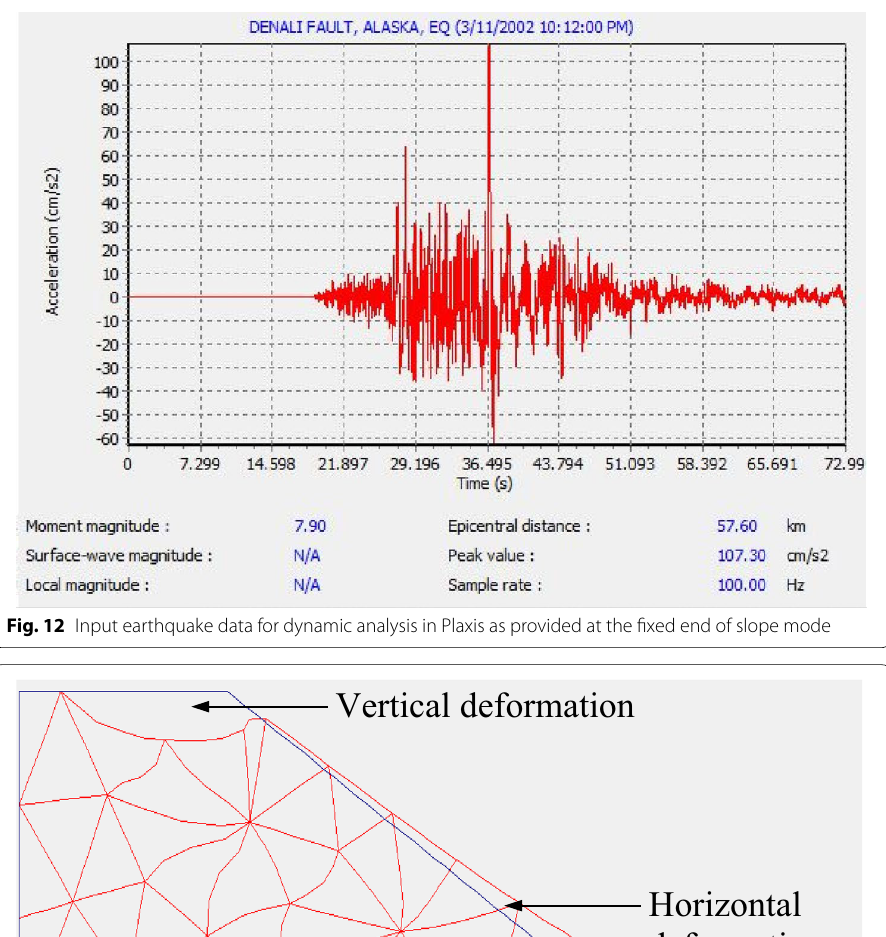
Fig. 13 The plot of deformed mesh due to the loadings (exaggeration factor: